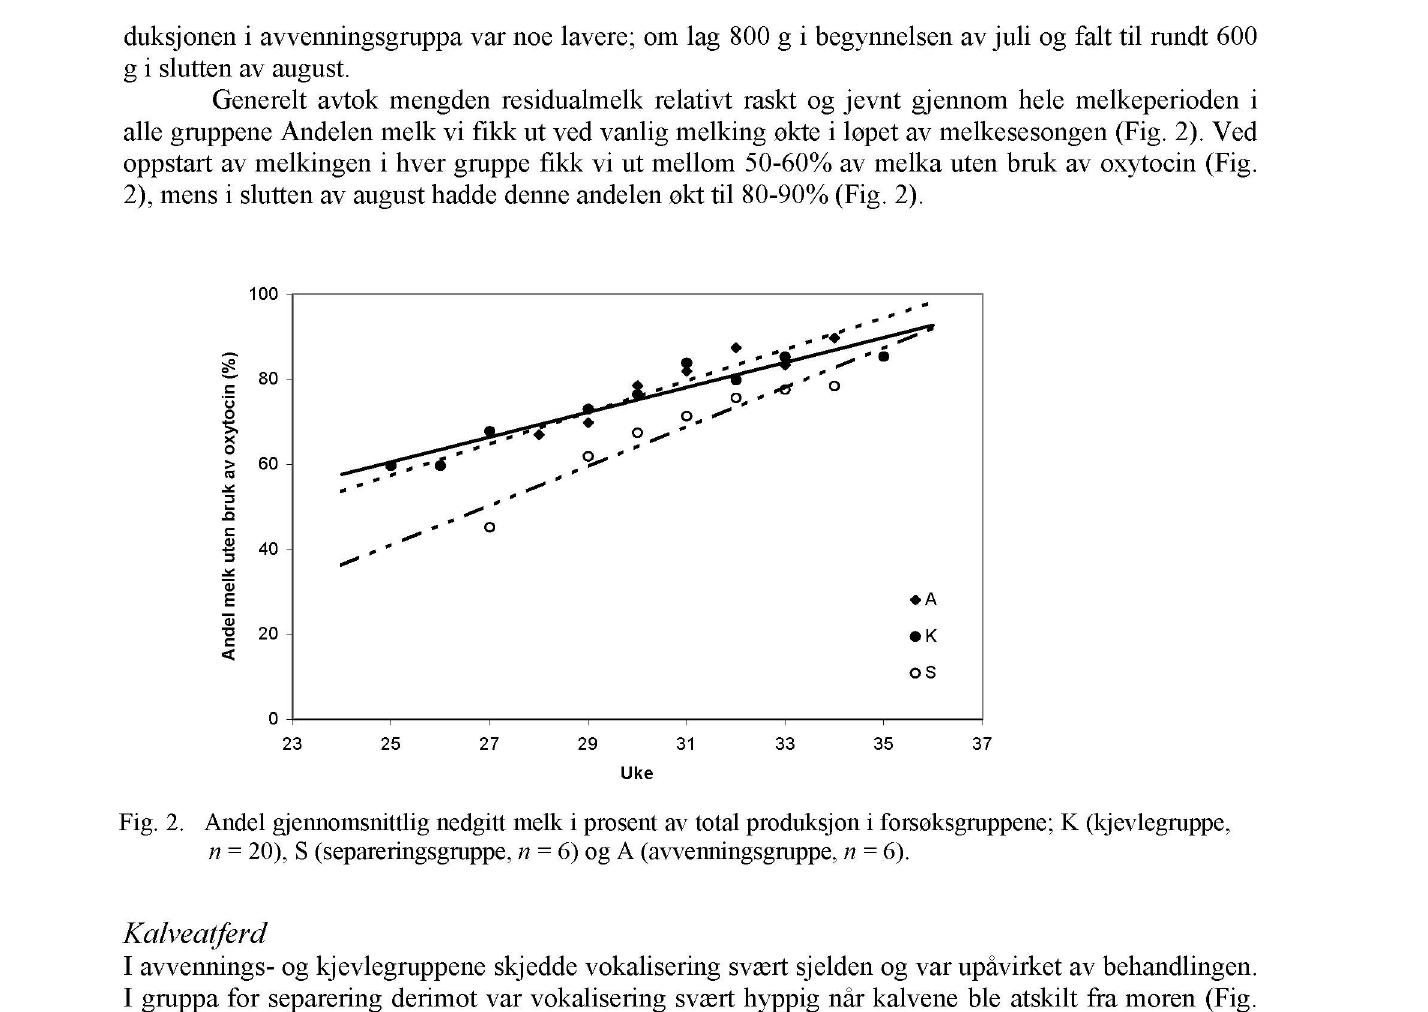
Fig. 2. Andel gjennomsnittlig nedgitt melk i prosent av total produksjon i forsøksgruppene; K (kjevlegruppe, n = 20), S (separeringsgruppe, n = 6) og A (avvenningsgruppe, n = 6).